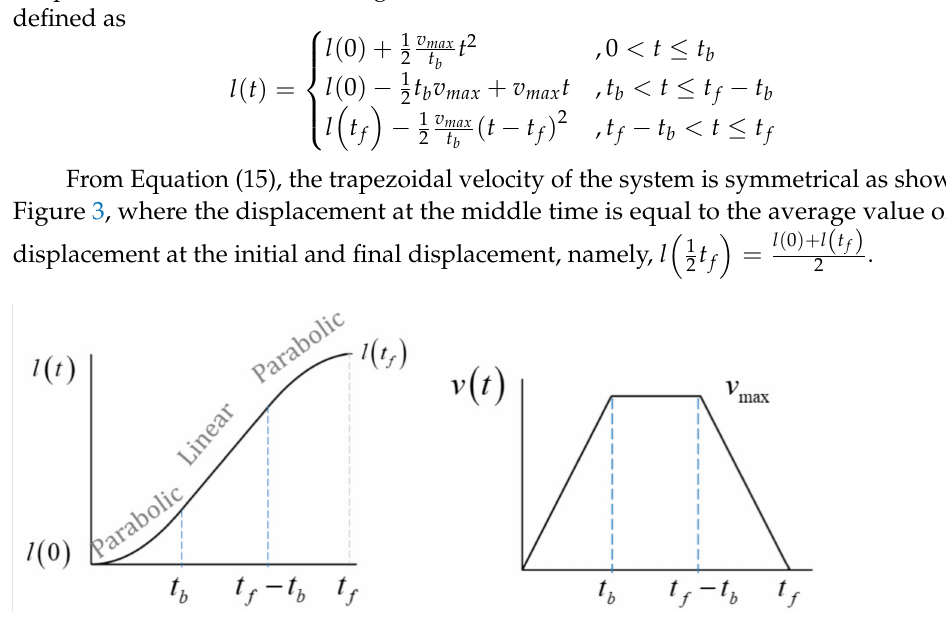
Figure 3. Motion